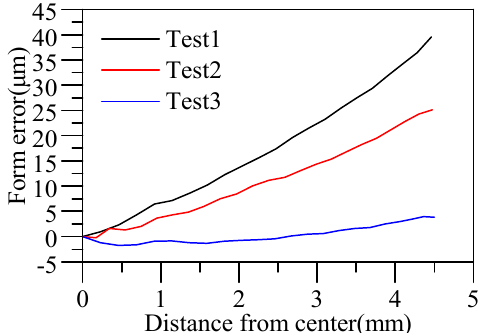
Figure 14. Surface profile contrast between the simulation and experiment: ( a ) surface 1; ( b ) surface 2.